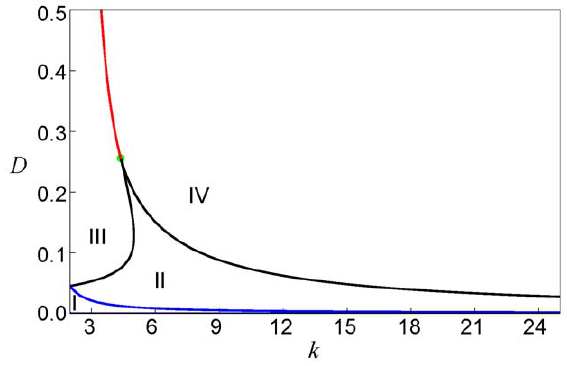
Figure 7. The bifurcation diagram. Regions with different dynamical regimes are shown in the parametric plane k { D . Black curves indicate the saddle-node bifurcations given by the Eq. (8), while the blue curve stands for the saddle-node bifurcations given by Eq. (11). The green dot indicates the cusp point given in Eq. (9), the red curve shows the boundary determined by Eq. (10). The model parameters are r 1 ~ 1, r 2 ~ 1 : 4 and r 3 ~ 3 .